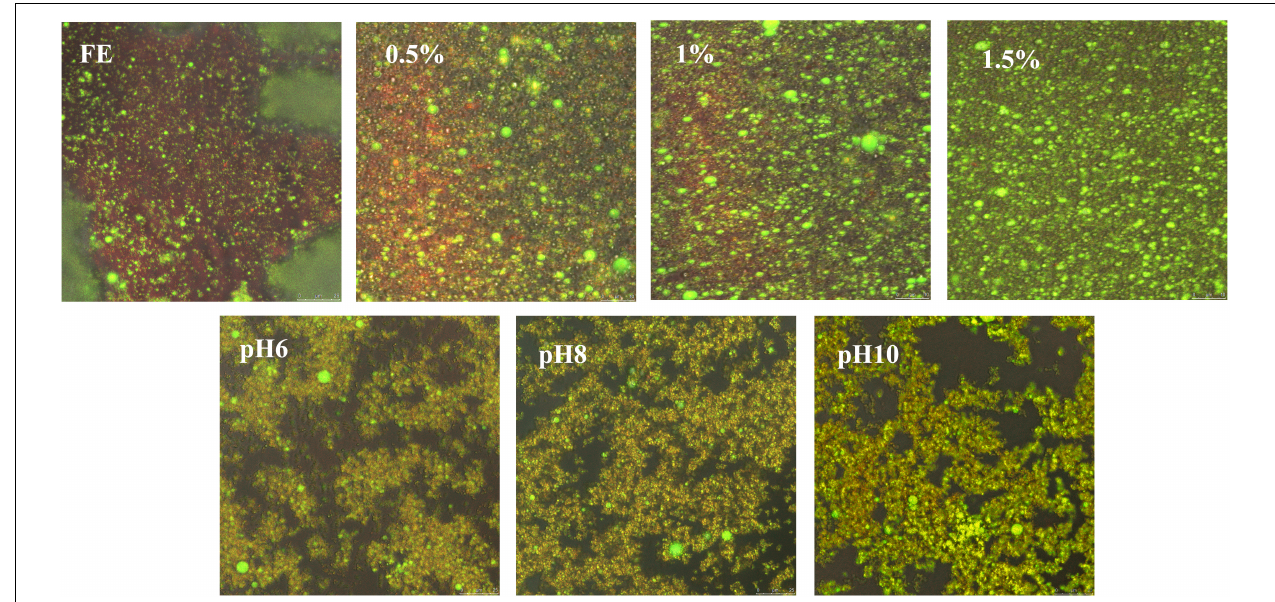
FIGURE 2 | Confocal laser scanning microscopy of complex